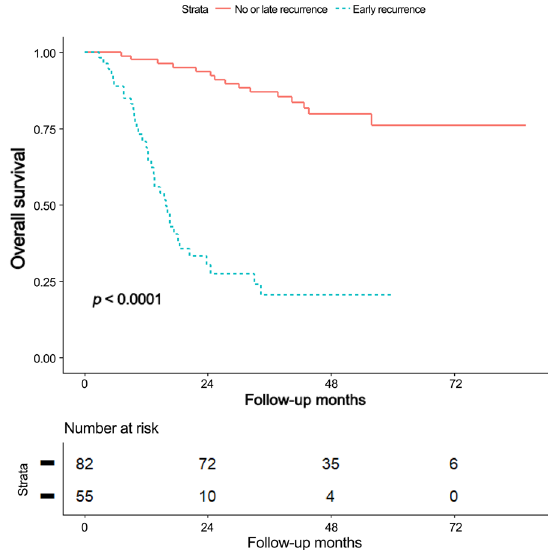
Figure 1. Overall survival (OS) of pancreatic ductal adenocarcinoma (PDAC) patients according to the recurrence group. The Kaplan-Meier curve showed that the early recurrence group had significantly poorer OS than the no or late recurrence groups.